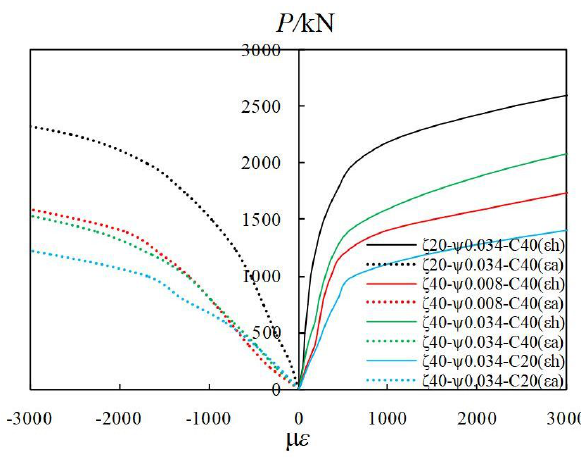
Figure 10: Load-strain curves of the specimens